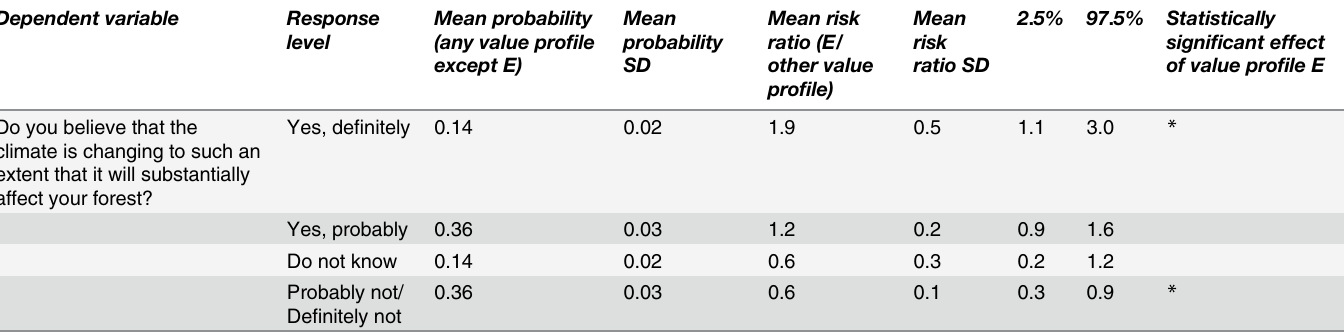
Table 4. Predicted probabilities for strengths of belief in the local effects of climate change based on value profile, and relative risk ratios for strengths of belief in the local effects of climate change based on value profile (with the education level represented by its proportion of those hav- ing studied at university) using the model for Swedish respondents (S5